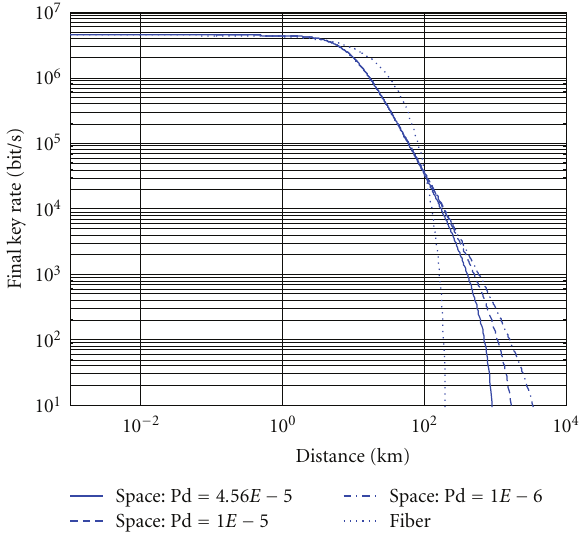
Figure 15: Final key rates achieved with BB84 and for the decoy state with μ = 0 . 5photons/pulse for free-space and fiber-based transmission systems at the clock rate of 2.5 GHz as a function of transmission distance. Pd stands for dark count rate in counts/ pulse. The rest of parameters corresponding to the prototype model in Table 1 are